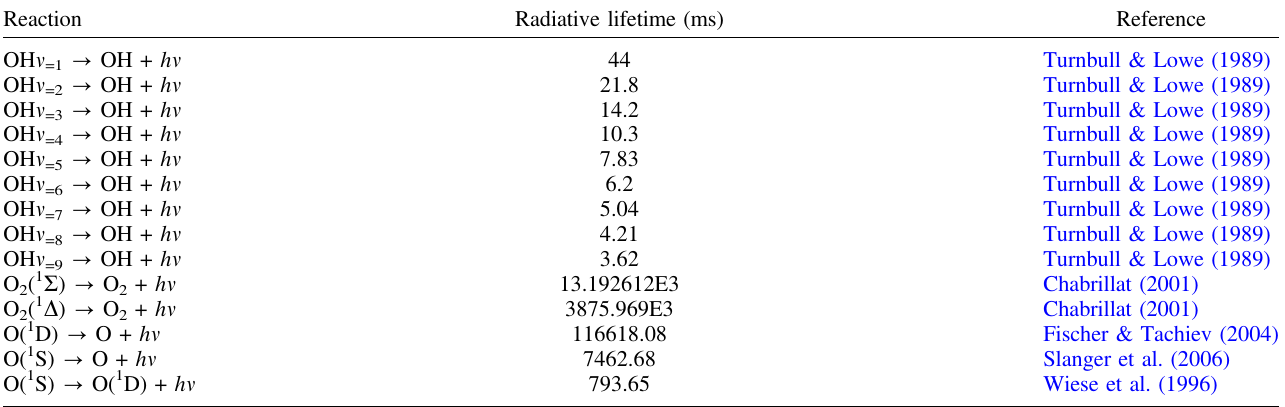
Table A.2. List of the emissions used in the model and the corresponding radiative lifetimes. Reaction